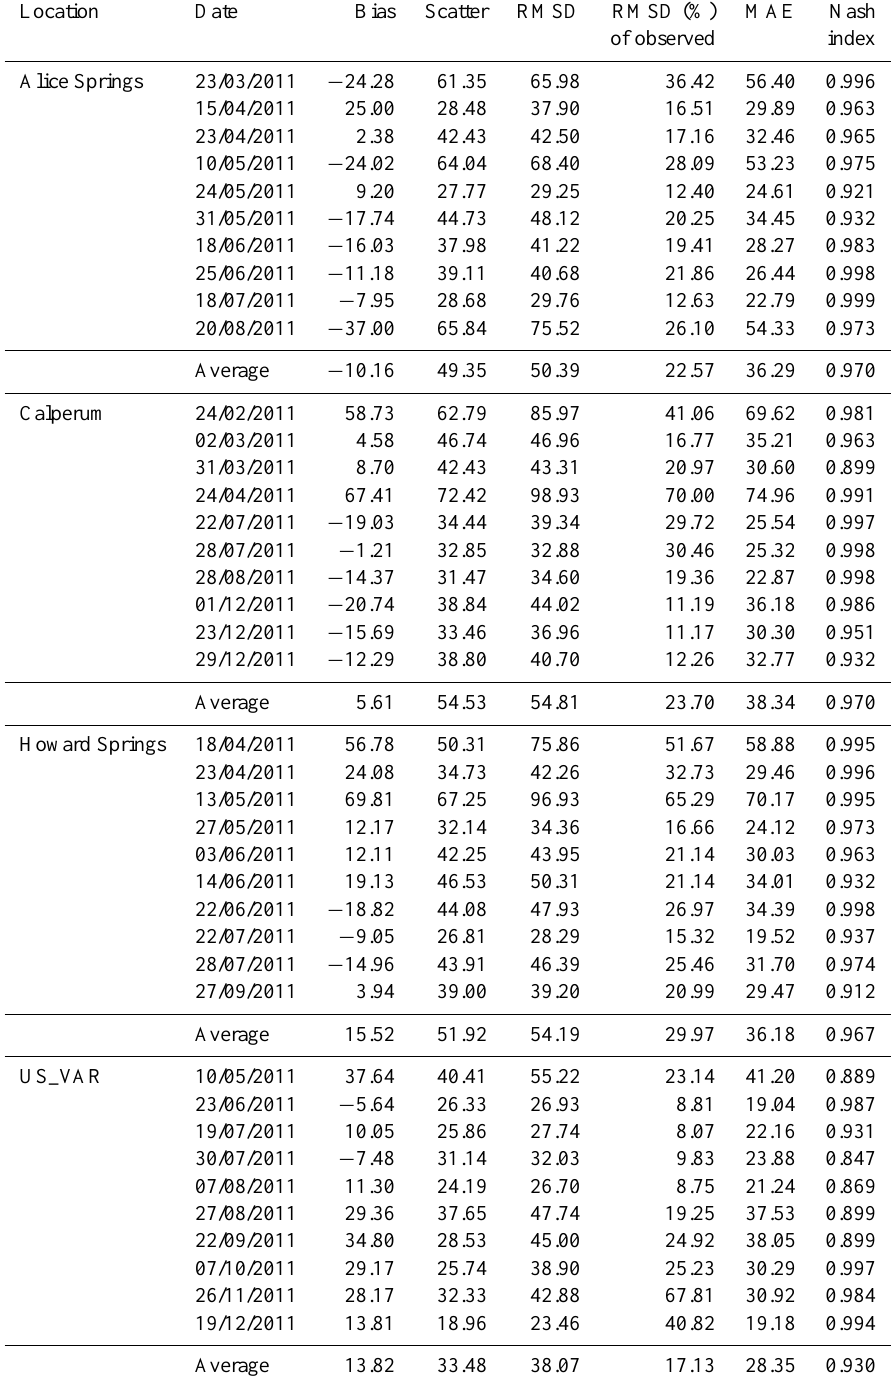
Table 6. Daily simulation accuracy and average site simulation accuracy for H fluxes. Bias, scatter, RMSD and MAE are expressed in Wm − 2 . Nash index is